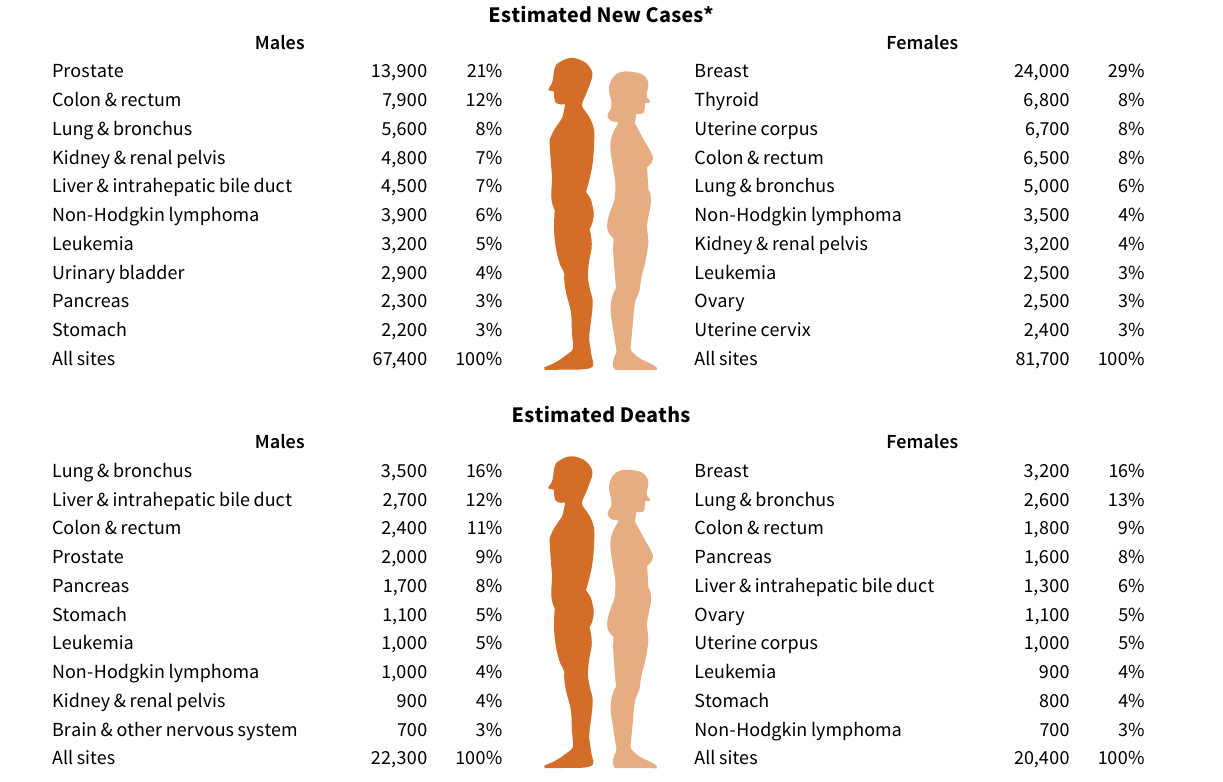
Figure 2. Leading Sites of New Cancer Cases and Deaths Among Hispanics – 2018